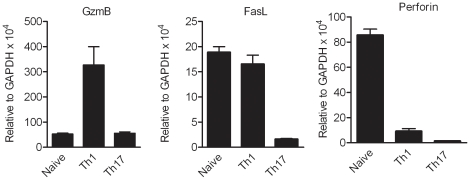
Cytotoxic molecules expression by Th1 and Th17 cells.T cells from 2D2 mice were activated under Th1 and Th17 polarizing conditions. Expression of granzyme B, Fas-L and perforin in naive T cells (n = 4), Th1 (n = 6) and Th17 cells (n = 7) were measured by real time PCR. The data is represented as mean ± SEM.